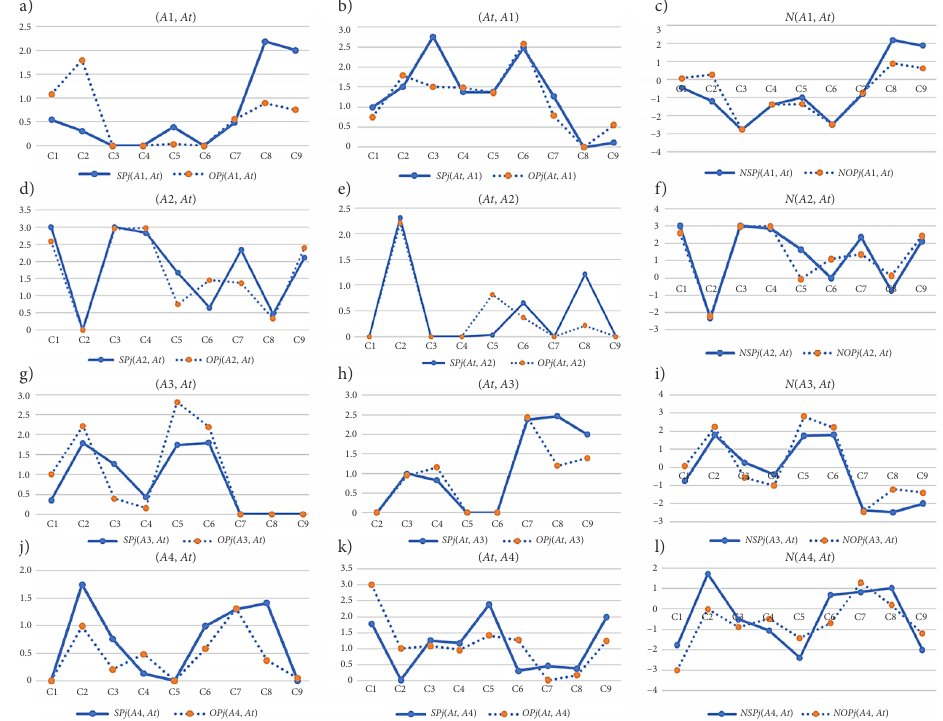
Figure 4. The comparision between the subjective preference and the objective